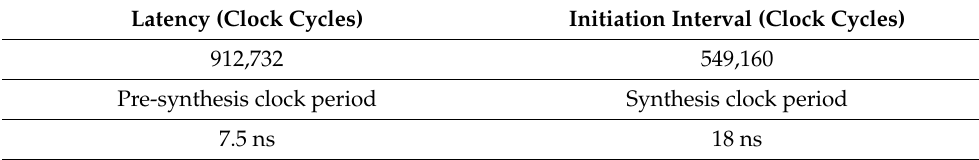
Table 4. Timing summary baseline CNN1D as reported in Vivado HLS and after the synthesis in